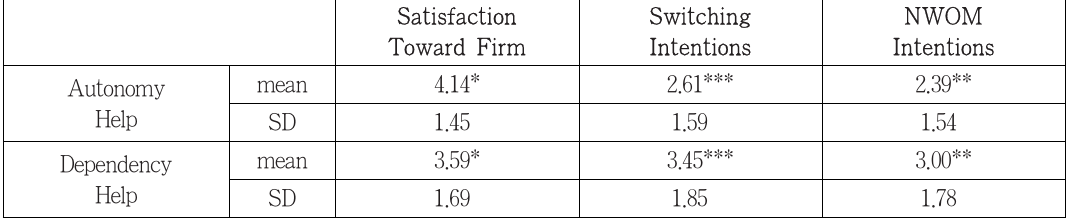
<Table 1> Effects of customer help on satisfaction and behavioral consequences (Study